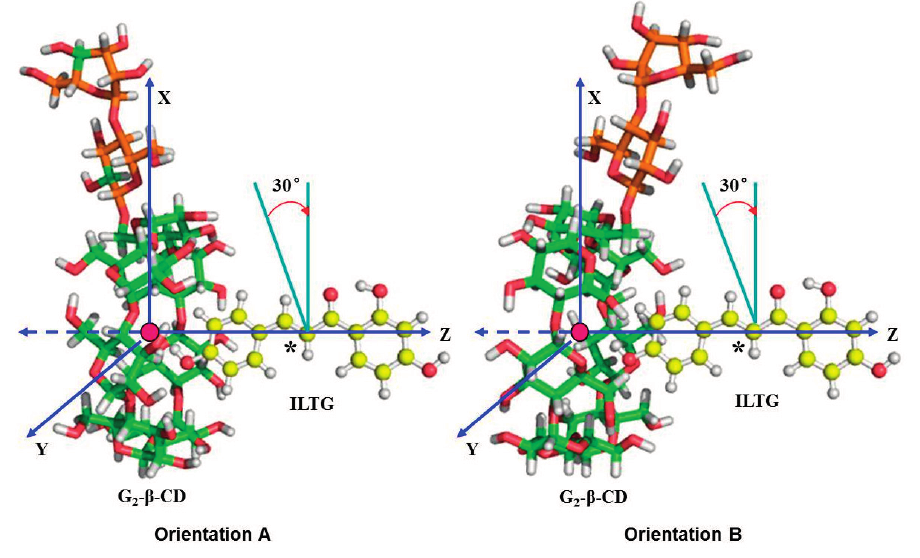
Figure 11. Binding orientations used to define the inclusion processes of - β -CD with ILTG. ILTG is displayed in yellow by ball and stick while G 2 - β -CD is displayed in a combination of green ( β -CD) and orange (G 2 ) by stick. Orientation A denotes that ILTG enters into the cavity from the wide rim of G 2 - β -CD, while Orientation B denotes that ILTG enters into the cavity from the narrow rim of G 2 - β -CD. The position of ILTG is determined by the Z -coordinate of the labeled carbon atom ( * ) from the center of the glycosidic oxygen